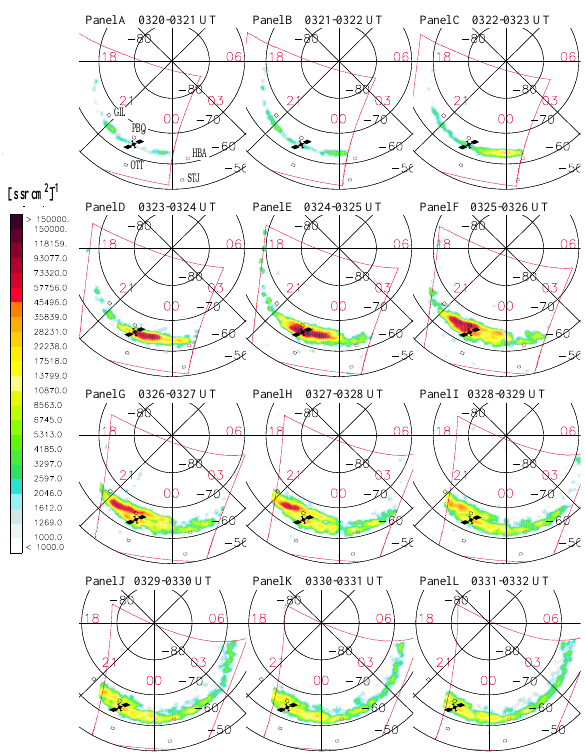
Fig. 3. PIXIE images from the substorm, 24 July 1998, energy range from 2.42–8.82keV photons. The coordinate system is cor- rected geomagnetic coordinates (cgm). Local midnight is straight downwards. The ground stations are marked in panel ( a ) as follows: GIL: Gillam, PBQ: Poste de la Baleine, HBA: Halley Bay, STJ: St. Johns, OTT: Ottawa. Halley Bay is the only Southern Hemisphere station. The magnetic footprint of GOES-8 is marked in black.